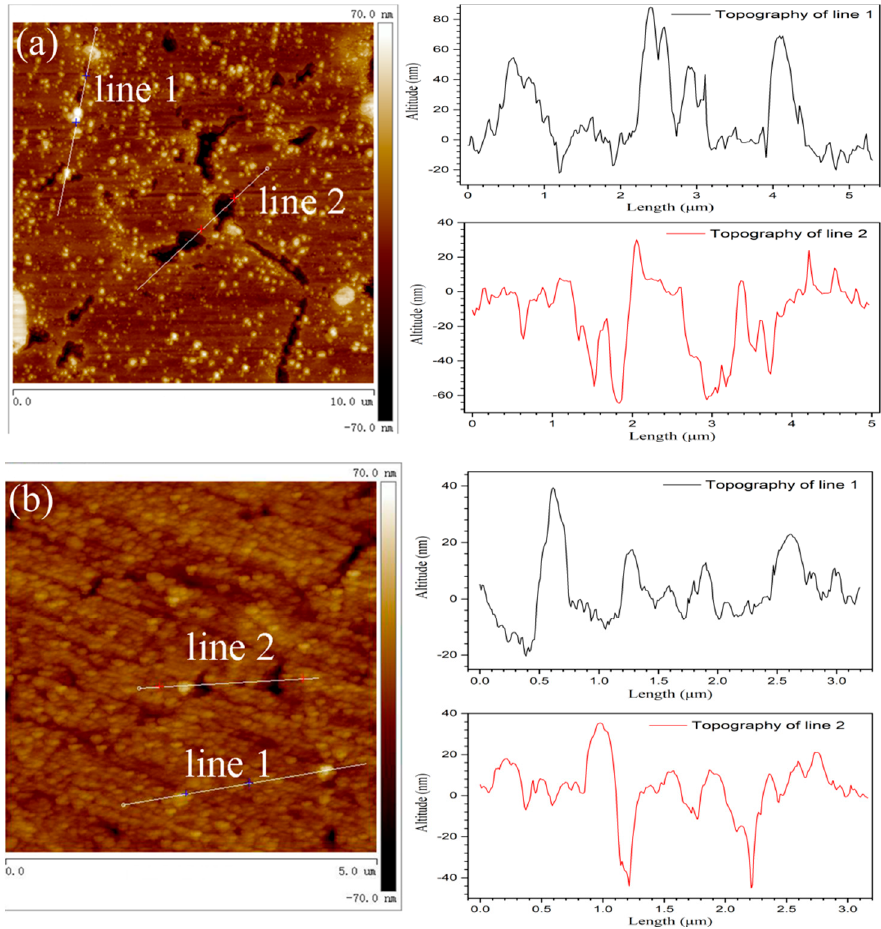
Figure 13. Atomic Force Microscope (AFM) images of 30 days air-exposed alloys after 1 h immersion in 3.5%wt NaCl solution, ( a ) coarse grain zone, and ( b ) fine grain zone.